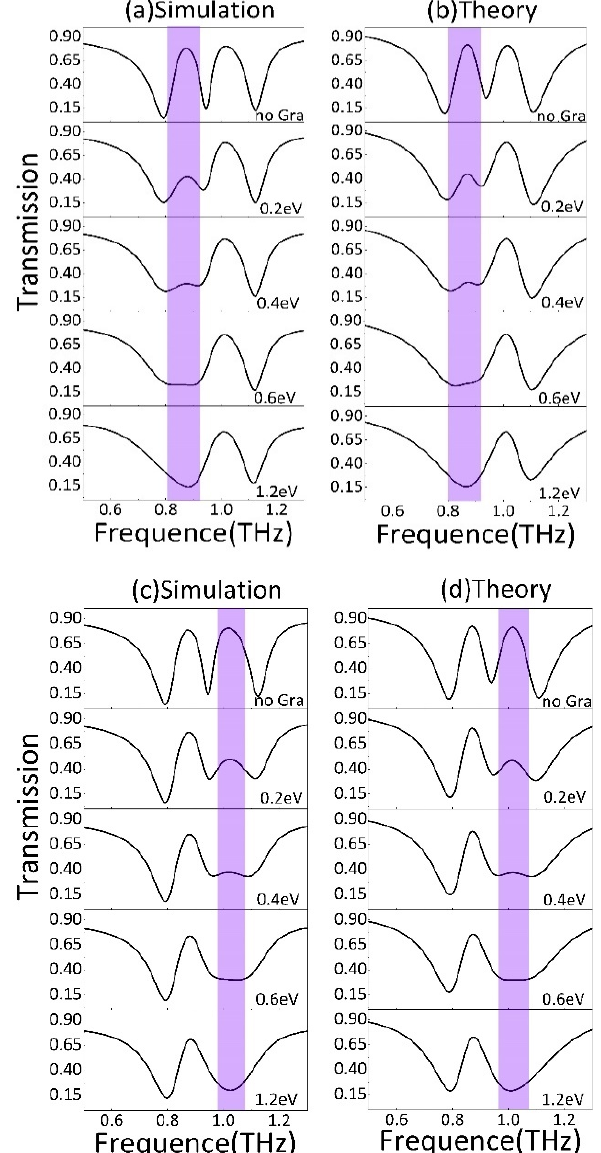
Figure 5. ( a ) The simulated and ( b ) analytical fitted transmission spectrum with different Fermi levels of strip 2. ( c ) The simulated and ( d ) analytical fitted transmission spectrum with different Fermi levels of strip 1.